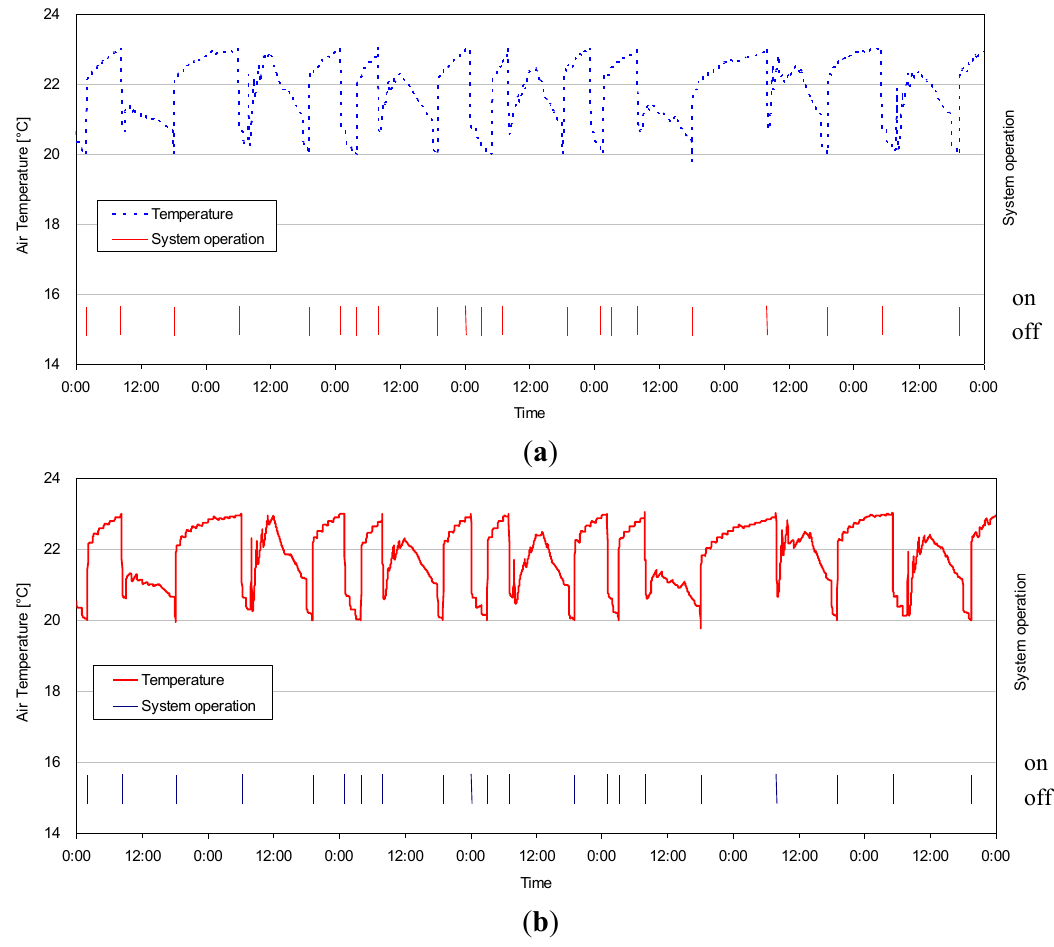
Figure 9. Indoor temperature and operation of heating system (Double Skin